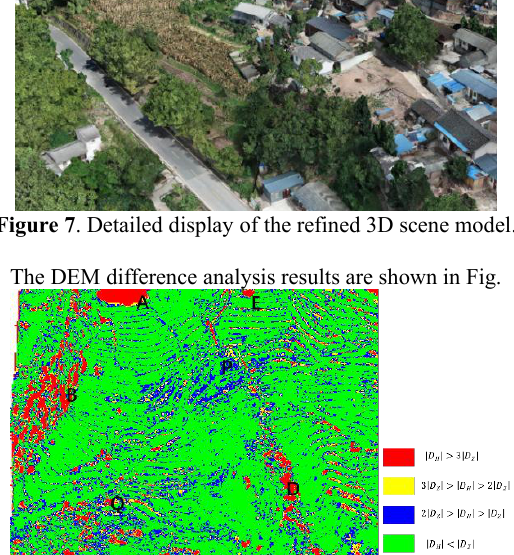
8. Figure 8 . DEM difference analysis results. The generalized orthophotos produced for the deformed region are shown in Fig. 9 and Fig.10.